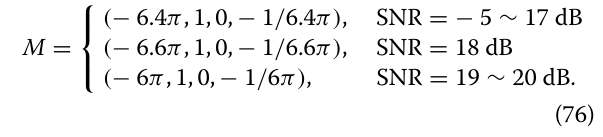
After digitalization, the length of the sequence is N = 1024 and the sampling frequency is F s = 100 Hz . The phase parameters of the signal are k 0 = 3 and ω 0 = 1. The envelope parameters are t 0 = 5 and σ = interference’s phase parameters are v = − 0.3, u = 6, and = 10. The amplitude is a = ω 1